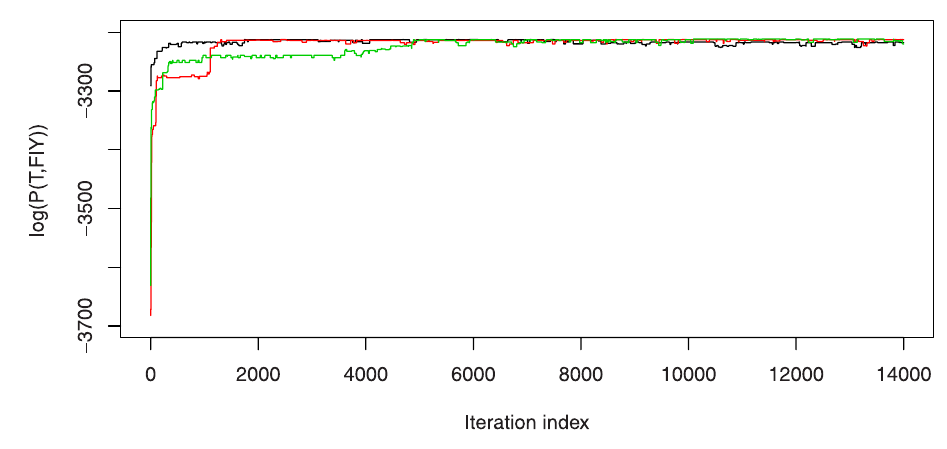
Fig. 1. Trace plots of the unnormalized log-posterior probability of the Markov chain for real cell-cycle data. Each line represents an independent Markov chain. Each chain is run for 14,000